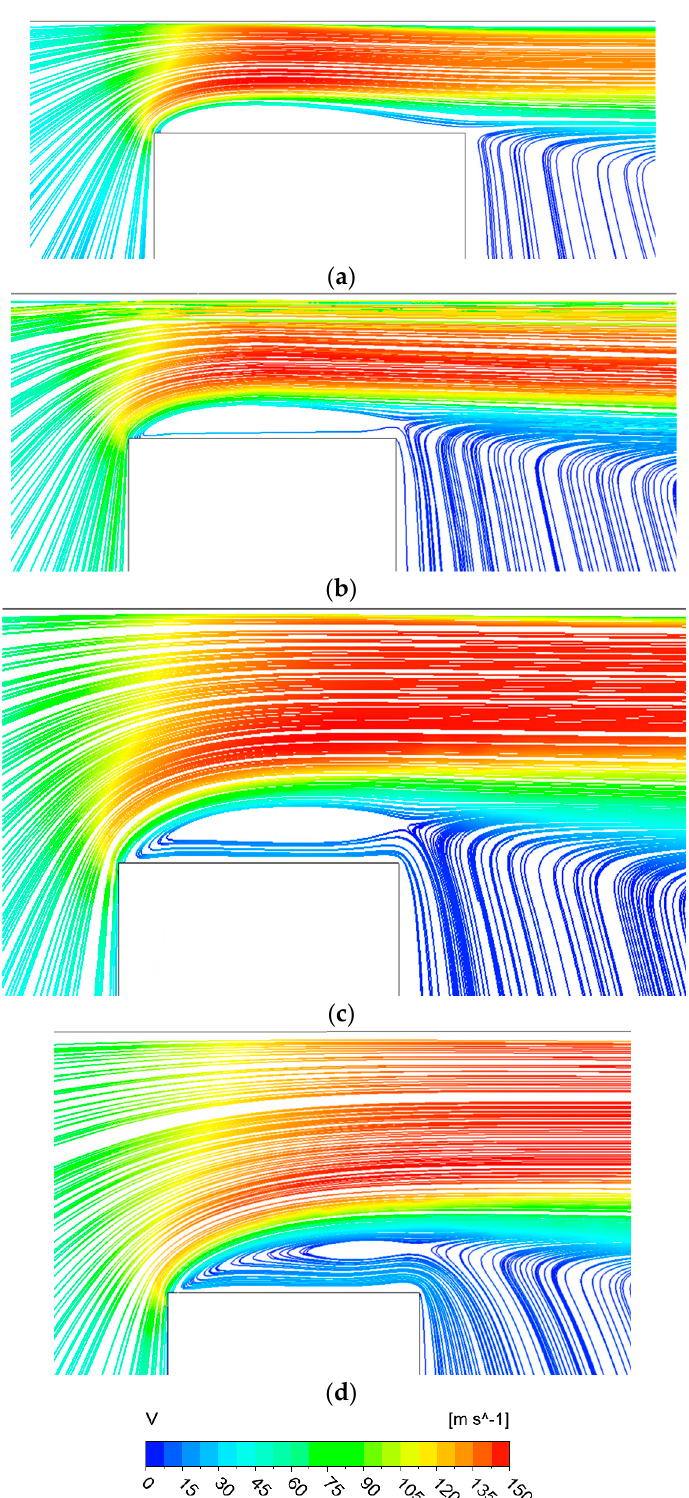
Figure 9. S treamlines and the velocity in clearances ( a ) 0.362, ( b ) 0.542, ( c ) 0.752 and ( d ) 1.067 mm high.